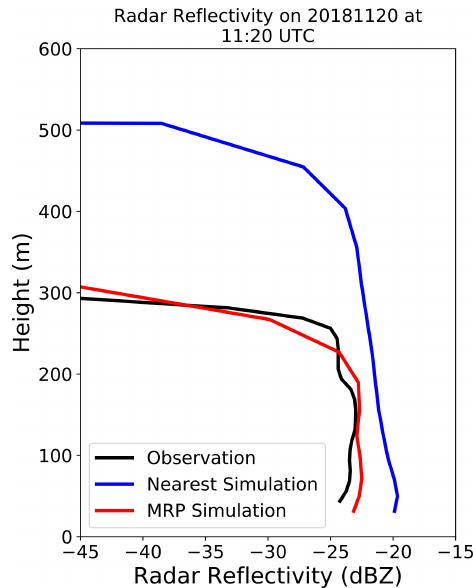
Figure 8. Radar reflectivity profiles of the observation, simulation from the nearest grid point, and MRP simulation from the mature phase of the fog event at SIRTA on 22 November 2018. At this point in the fog event, the model overestimated the thickness of the fog layer by around